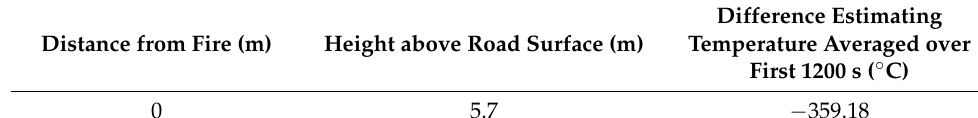
Table 6. Difference estimating temperature, averaged over first 1200 s.